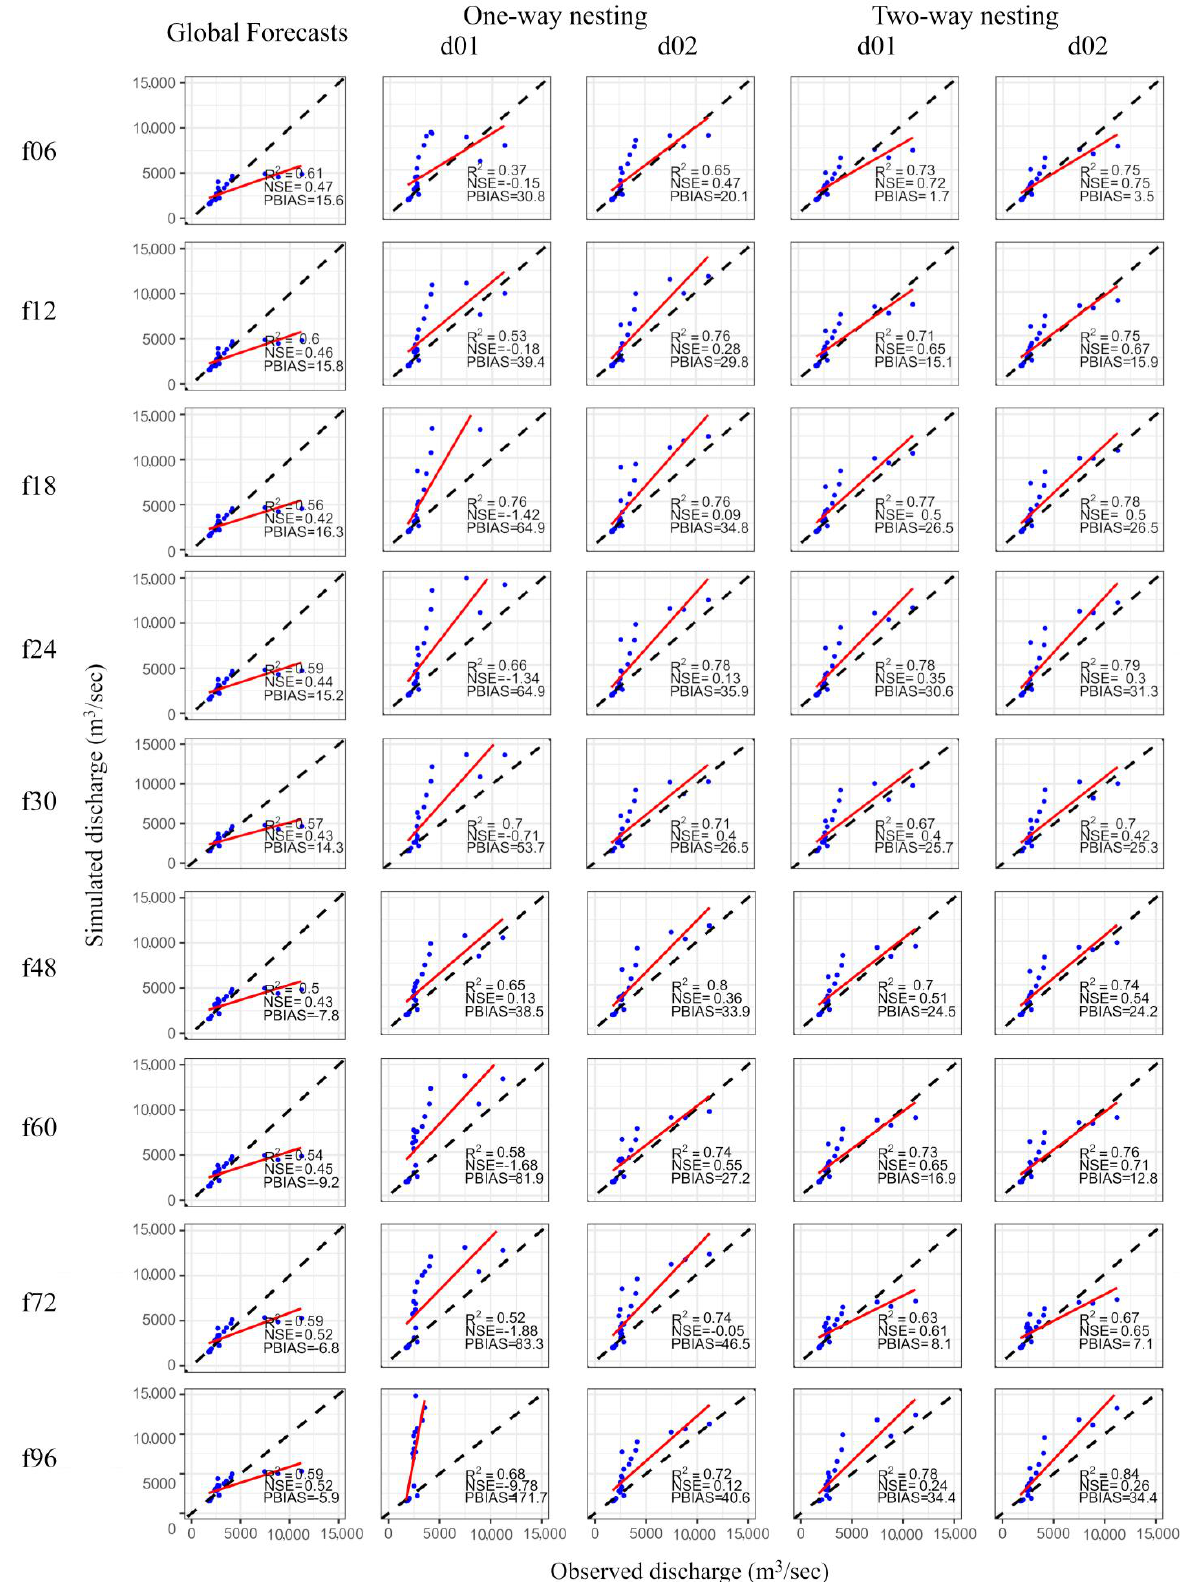
Figure 7. Scatter plot and performance evaluation indices (R 2 , NSE, and PBIAS) of simulated flows driven by the global, one-way nesting, and two-way nesting WRF